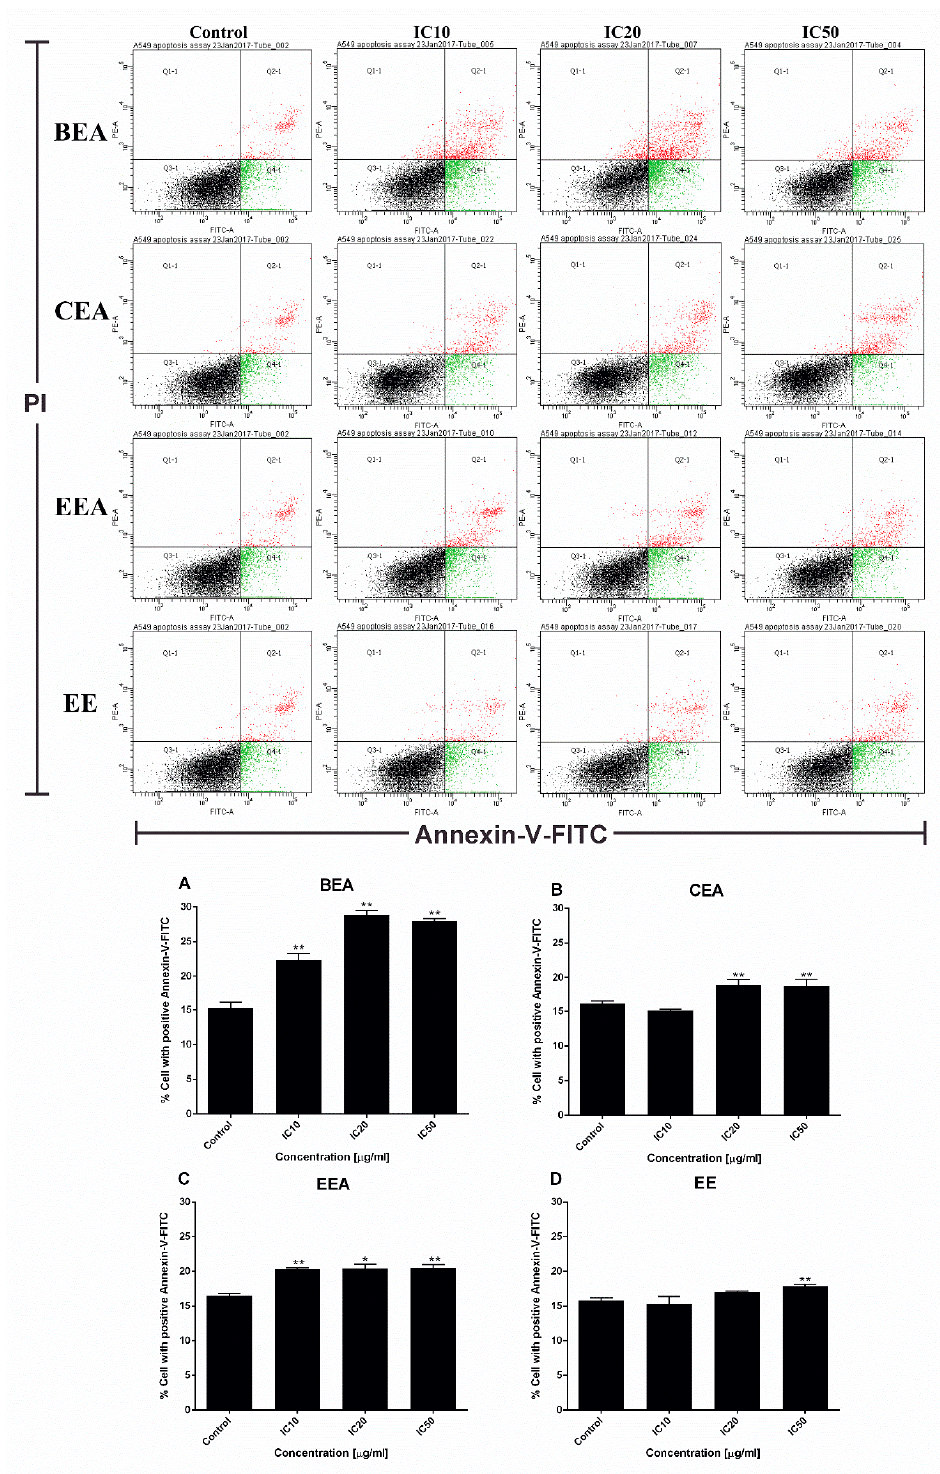
Figure 6. E ff ective extracts induced A549 cell apoptosis detected by flow cytometry. A549 cells were stained with annexin V-FITC and PI after treatment with the e ff ective extracts for 24 h. Dot plots show annexin V-FITC +/ PI − as early apoptotic cells and annexin V-FITC +/ PI + as late apoptotic cells. Early and late apoptotic cells accumulated as a percentage of cell apoptosis in the bar graphs of each extract; ( A ) BEA, ( B ) CEA, ( C ) EEA, and ( D ) EE. The data were reported as a mean ± SD of three independent experiments carried out in triplicate, * p < 0.05 and ** p < 0.01 compared to the control